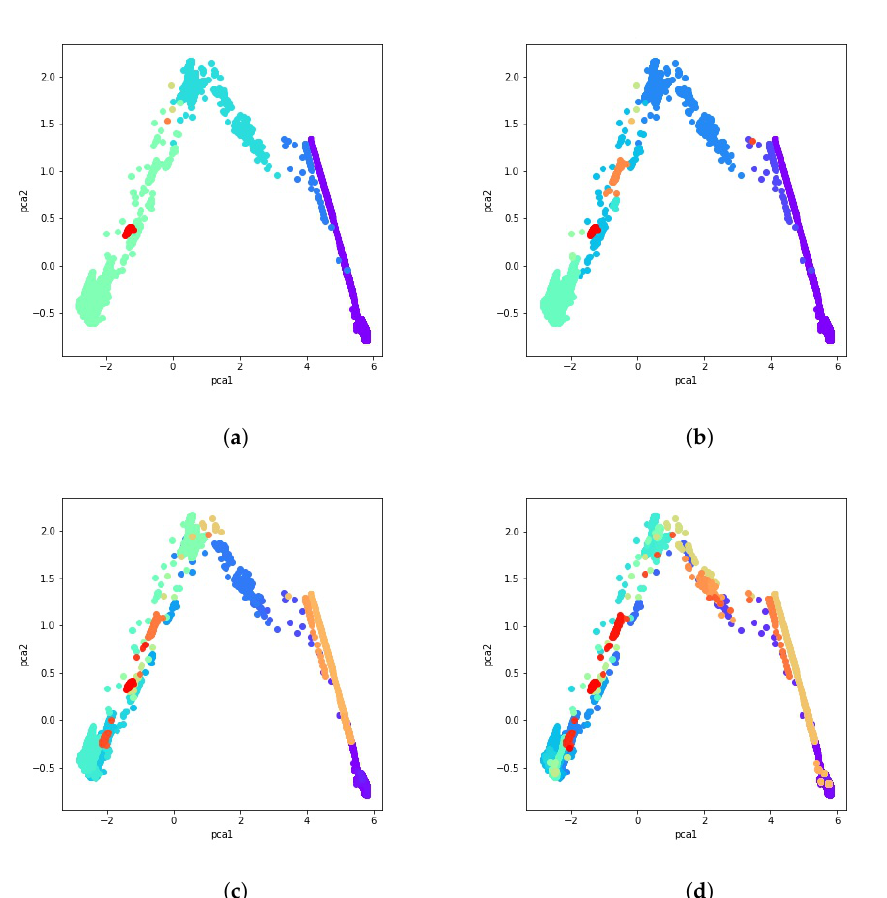
Figure 8. PCA visualization of the ensemble of clusters with several percentages of